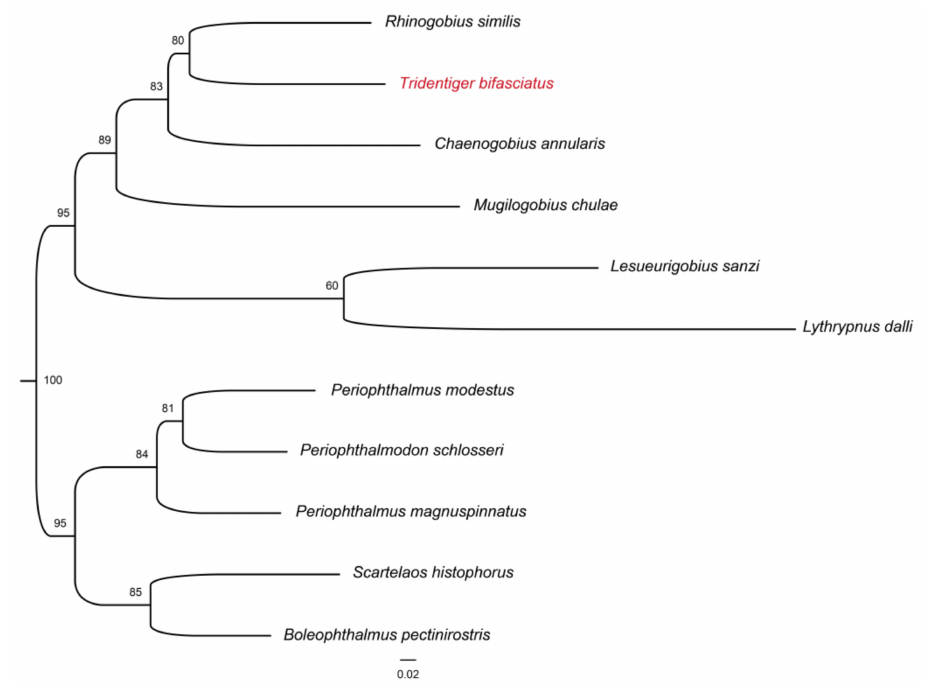
Figure 7. Phylogenetic tree of some species of Gobiidae based on single-copy homologous genes. Red font represents the species in this